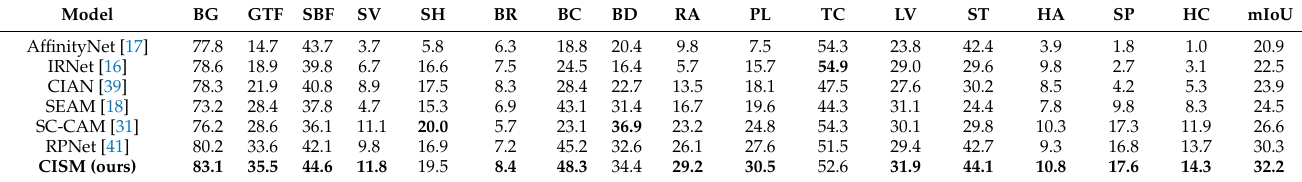
Table 1. The performance statistics of weakly supervised methods in the mIoU (%) on